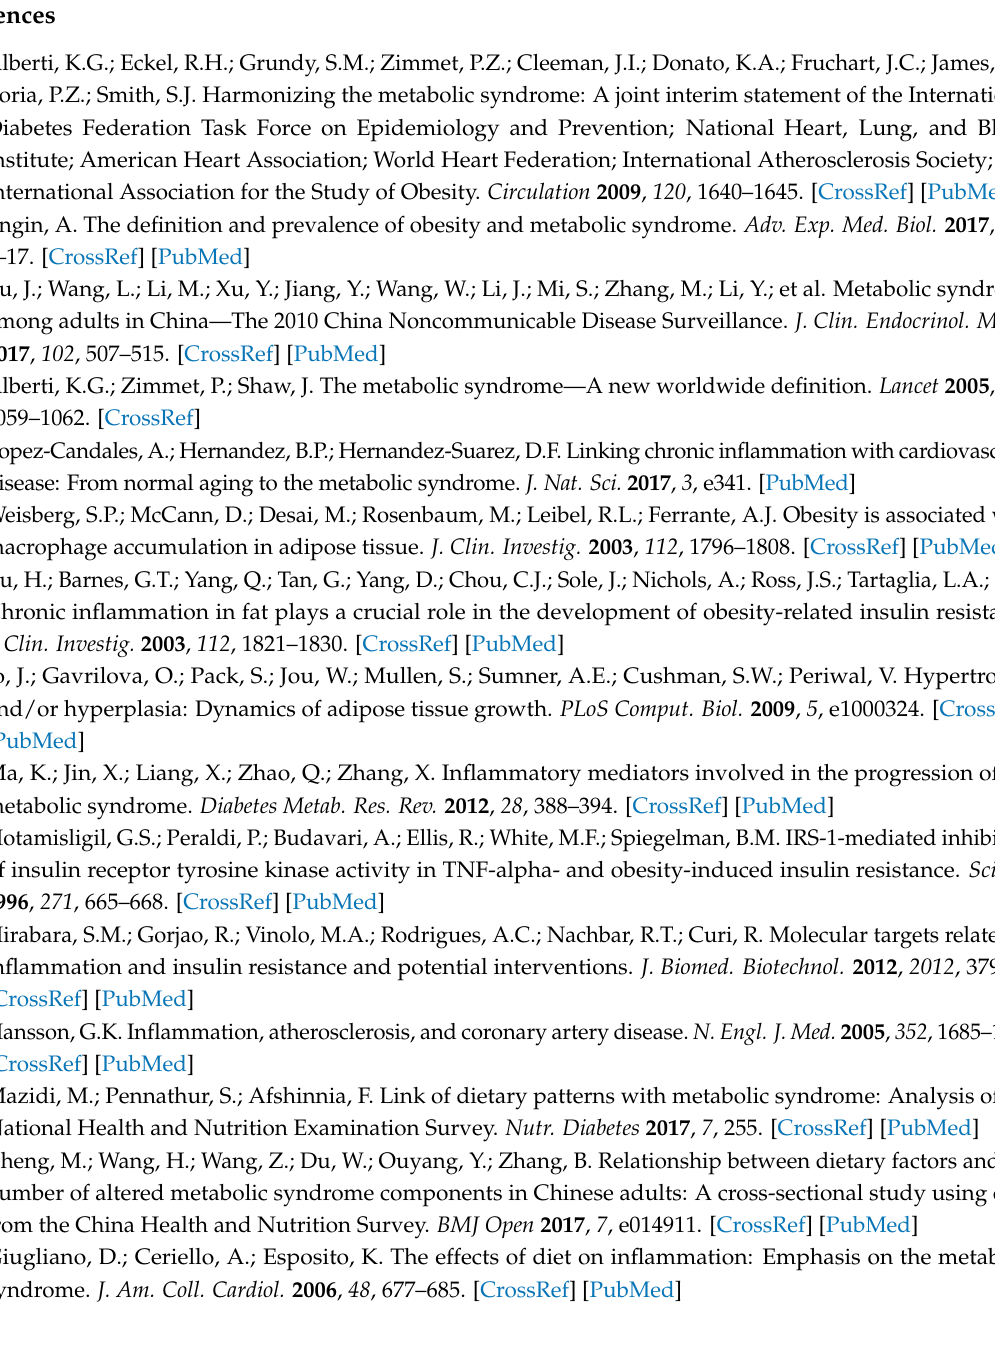
Table S1: Association between the incidence of MetS (components) and DII/CRP in supplementary analyses; Table S2: Stratified analysis of association between the DII and CRP by sex; Table S3: Association between the DII and CRP in supplementary